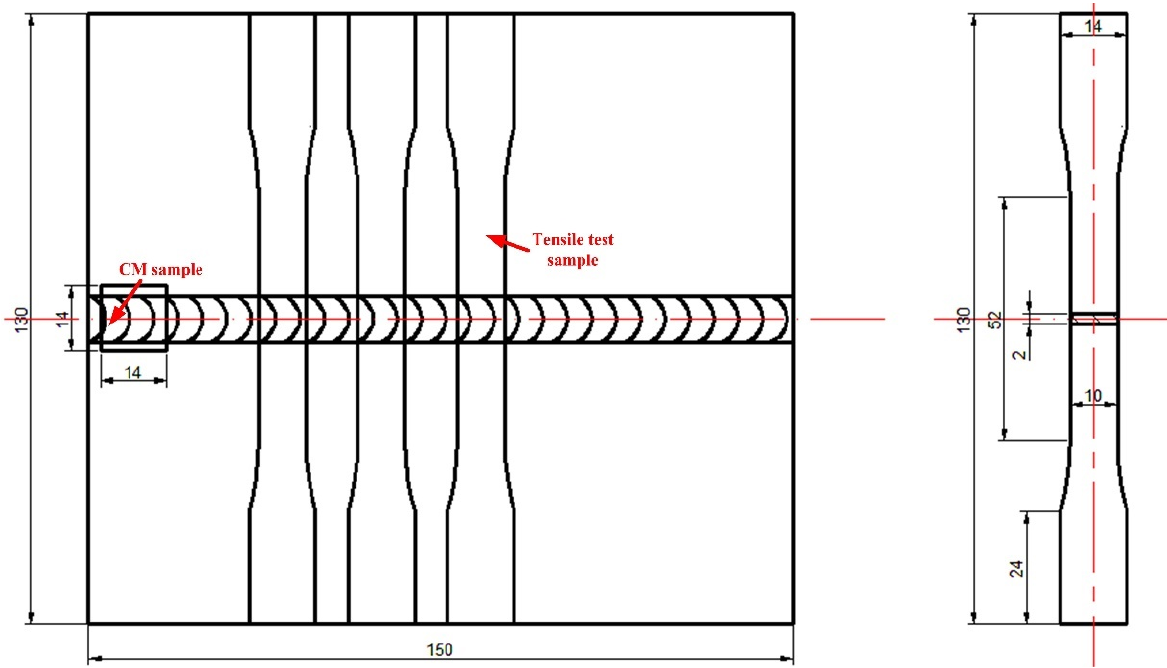
Figure 2. Extracting CM and tensile test samples from the butt-welding joints (unit: mm).